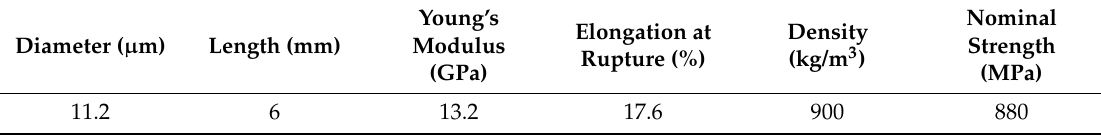
Table 1. The properties of PP fibres.